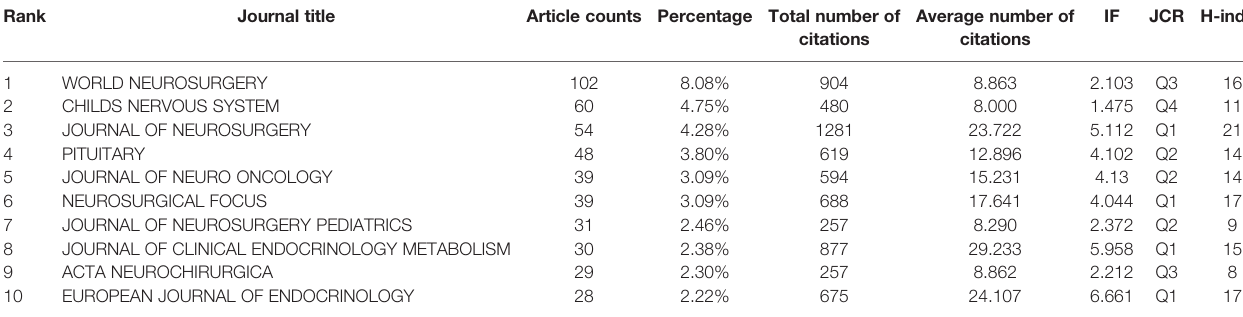
TABLE 2 | The top 10 most active journals that published articles in craniopharyngioma research (sorted by count). Rank